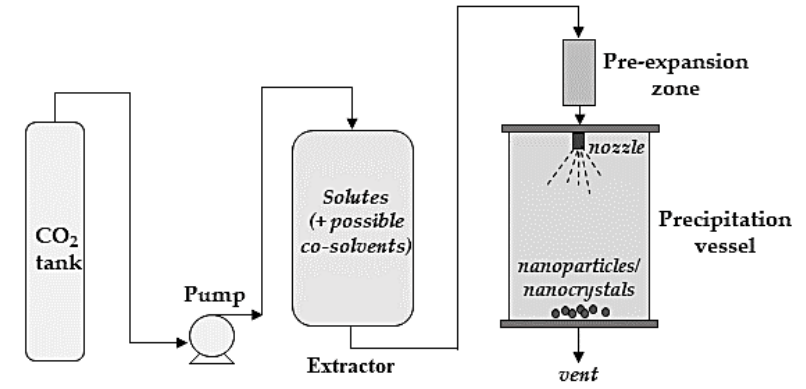
Figure 3. A sketch of the rapid expansion of supercritical solution (RESS) process.